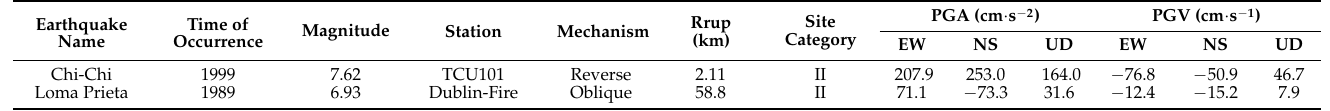
Table 1. Chi-Chi and Loma Prieta ground motion waveform